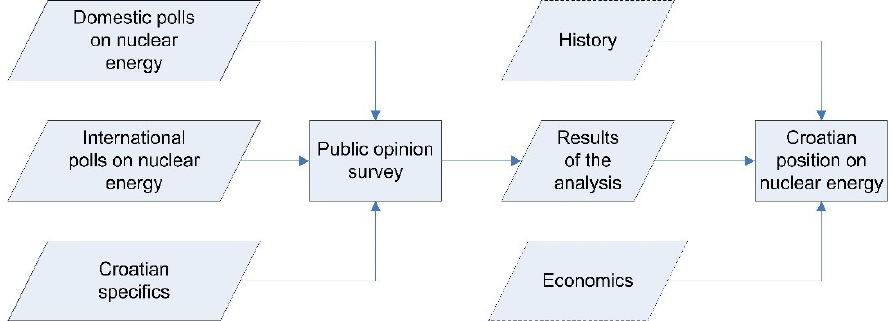
Figure 1. Methodology of the research.